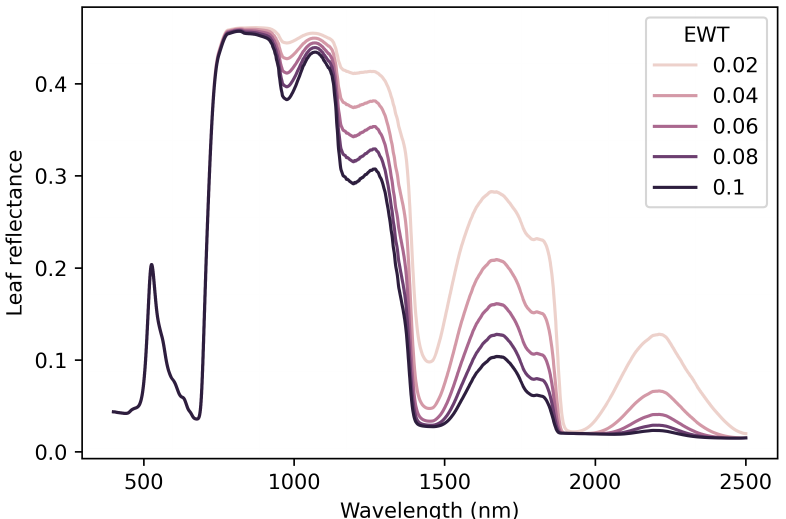
Figure 3. Simulated spectra of plant leaves with different equivalent water thickness (EWT) levels. Generated using the PROSPECT-D model [46], with leaf parameters set as: N = 1.5,